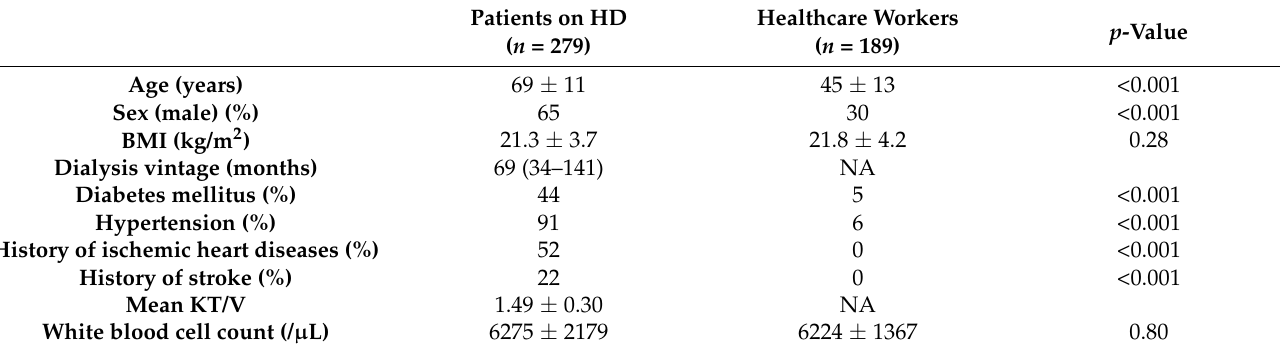
Table 1. Characteristics of the patients on hemodialysis and the healthcare workers. Patients on HD Healthcare